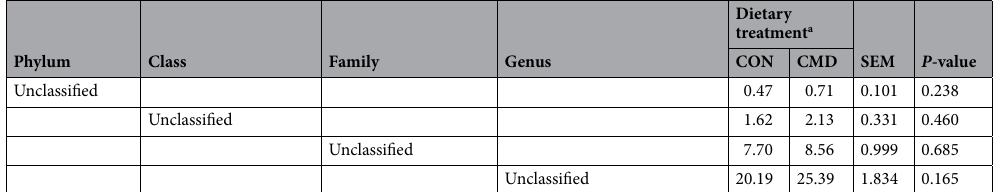
Table 6. Relative abundance (%) of rumen bacteria taxa (≥ 0.2% of average abundance) in lambs fed concentrate diets containing dehydrated lucerne (CON) or cardoon meal (CMD). SEM pooled standard error of the mean. a CON control diet, CMD cardoon meal diet.